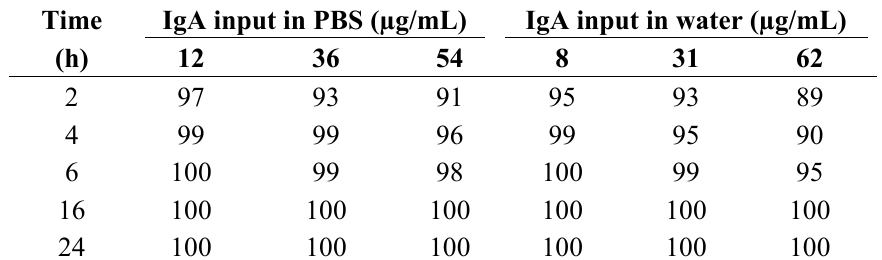
Table 4. IgA sorption yield, from protein solutions in water or PBS at different concentrations. CS-HA particles at a ratio R = 1.5 (CS Mw 130 × 10 3 g/mol and DA = 48% and HA Mw = 50 × 10 3